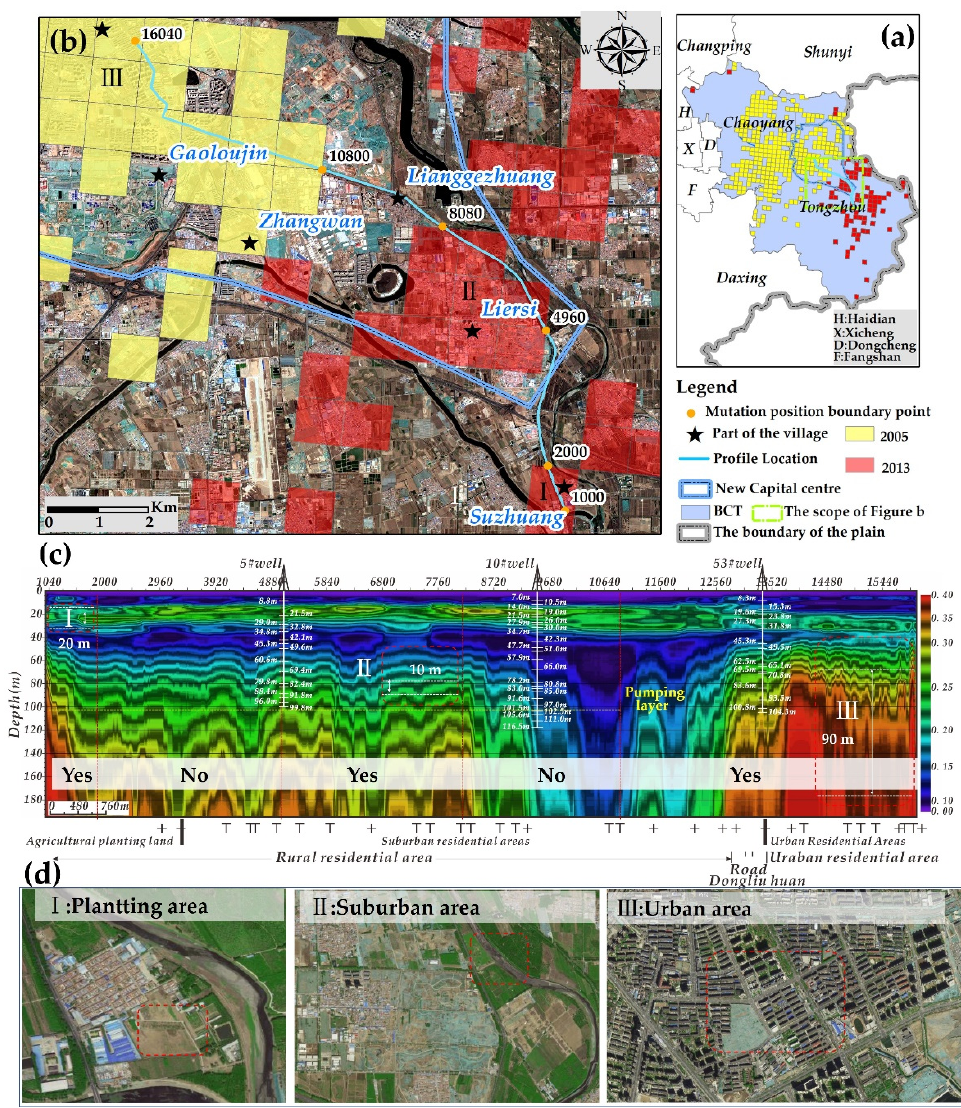
Figure 11. Response relationship between formation density and subsidence mutation in Tongzhou typical area. ( a ) refers to the location of the geophysical section. ( b ) refers to the information of the subsidence mutation and the boundary point of the mutation. ( c ) is the formation density informa- tion acquired by new geophysical prospecting technology. ( d ) shows land use in the subsidence mutation